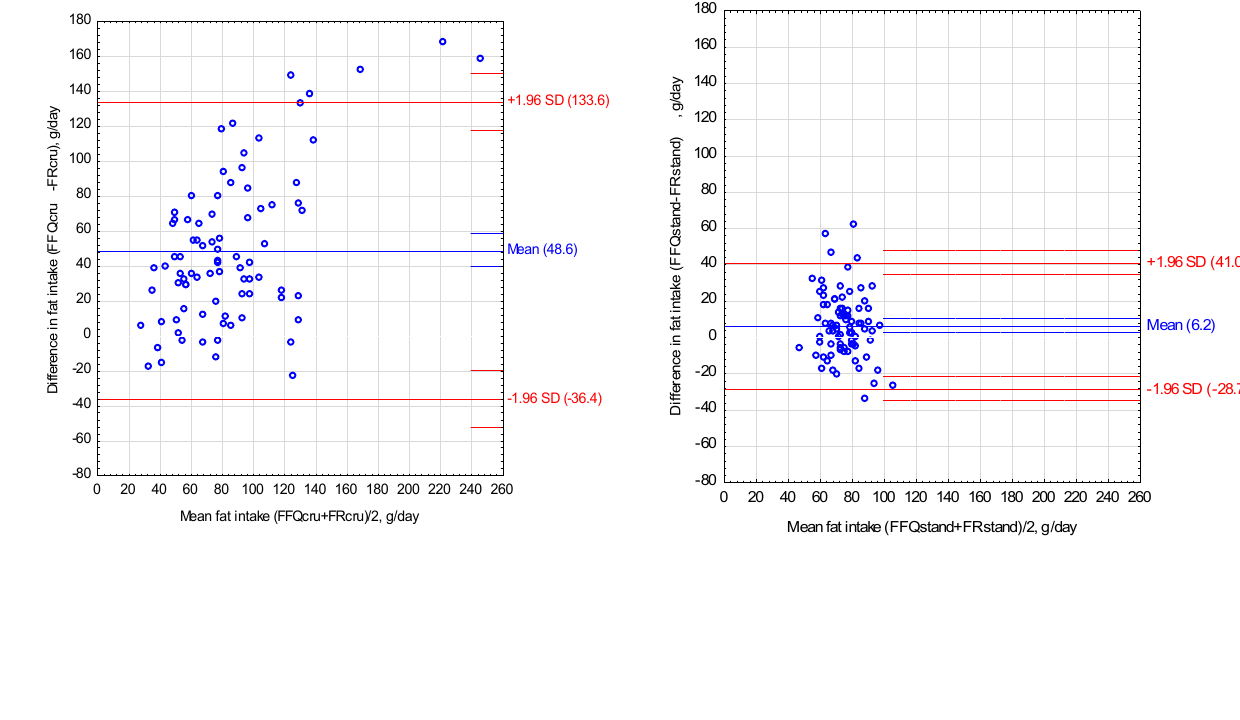
Figure 2. Bland-Altman plots to assess agreement between the food frequency questionnaire (FFQ) and three-day unweighted food record (FR) for fat intake in